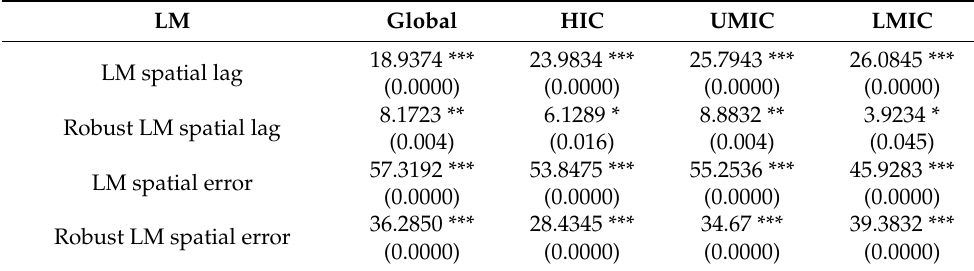
Table 13. LM residual test. LM